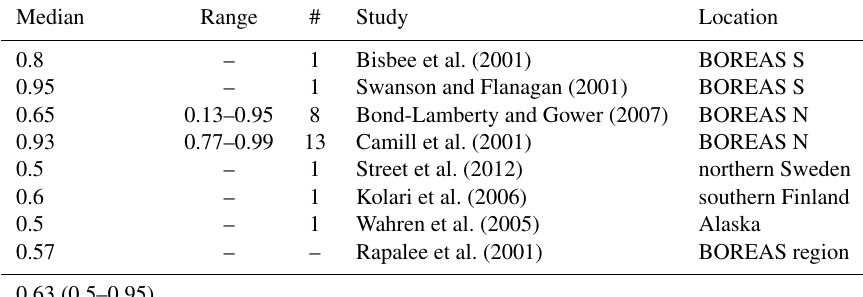
Table B2. Studies which measure surface coverage in the biomes boreal forest and tundra. Median and range of all values listed in a study are shown, # stands for the number of values. The BOREAS N study area is located in Manitoba, Canada and BOREAS S is located in Saskatchewan, Canada (Gower et al., 1997). The last row shows median and range of the values in the first